Question: Draft a figure caption describing what is shown.
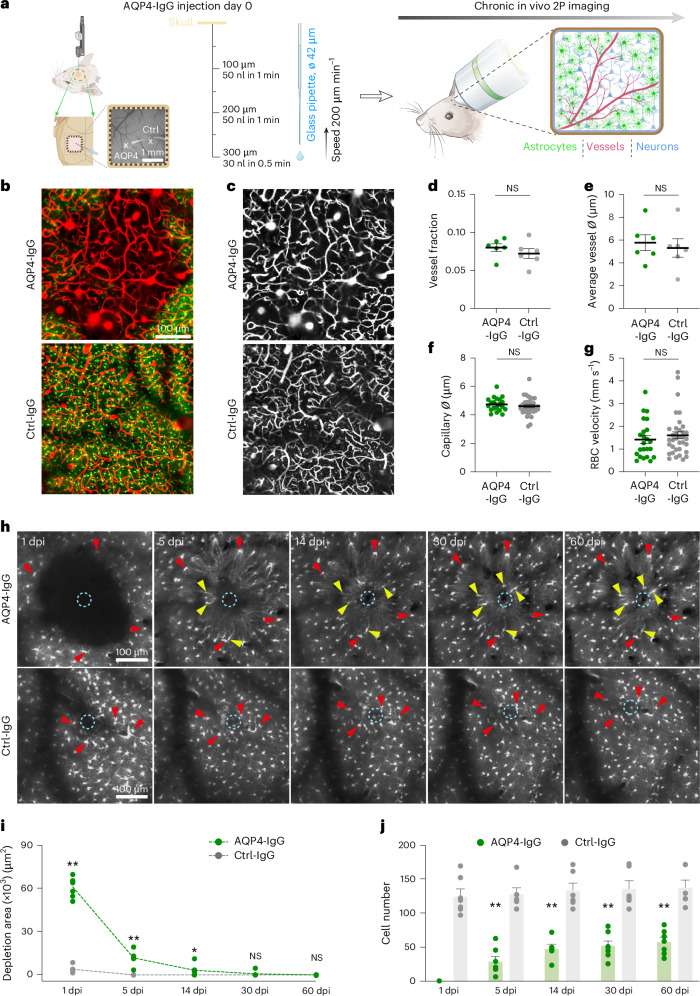
Answer: AQP4-IgG-based selective astrocyte depletion leads to efficient astrocytic lesion repopulation. a , Protocol of AQP4-IgG-based astrocyte depletion in the somatosensory cortex of anesthetized mice. Implantation of a permanent window allows chronic in vivo two-photon microscopy imaging. b , Projected two-photon image z stacks (100 µm) from Aldh1l1 GFP mice, demonstrating focal loss of astrocyte-expressing GFP signal. Vessels were visualized with administered intravenous injection of Texas Red dextran (70 kD). c , Z projections of the vascular channel from b (same scale as in b ). d – g , AQP4-IgG-mediated ablation of astrocytes does not alter vascular structure compared to the intracortical injection of a control antibody (Ctrl-IgG). Vessel fractions ( n = 6 animals per condition; d ) and average vessel diameters ( n = 6 animals per condition; e ) determined in vessel segmentations (Mann–Whitney test, two sided). Average capillary diameters (AQP4-IgG— n = 20 capillaries from three animals; Ctrl-IgG— n = 35 capillaries from three animals; f ) and RBC velocities in capillaries measured in vivo (AQP4-IgG— n = 20 capillaries from three animals; Ctrl-IgG— n = 35 capillaries from three animals; Mann–Whitney test, two sided; g ). h , Using longitudinal in vivo two-photon imaging in Aldh1l1 GFP mice, recoverage of the astrocyte-depleted area after AQP4-IgG injection was followed over 60 days (top). Cells in the direct vicinity of the lesion (perilesional astrocytes, red arrowheads) remain in their location throughout the experimental time period. Within the initially astrocyte-depleted area, an increasing number of newly appearing astrocytes are detected (yellow arrowheads) over time. Bottom: after Ctrl-IgG injection, cells in the direct vicinity of the injection site (cyan dashed circles) are present throughout the whole follow-up period (red arrowheads). i , j , Quantification of mean depletion area size over time (AQP4-IgG, 1 dpi, 14 dpi, 30 dpi and 60 dpi— n = 7 lesions f